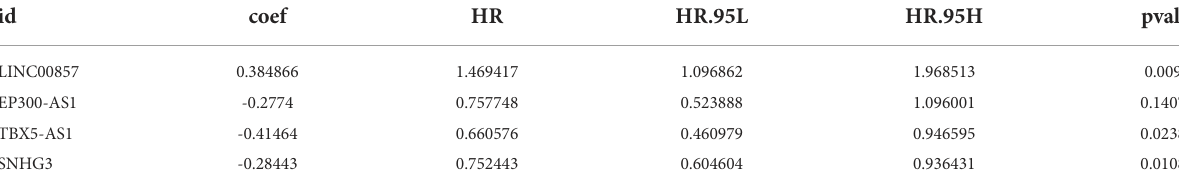
TABLE 3 4 prognostic signatures were identi fi ed by multivariate Cox regression analysis. id coef